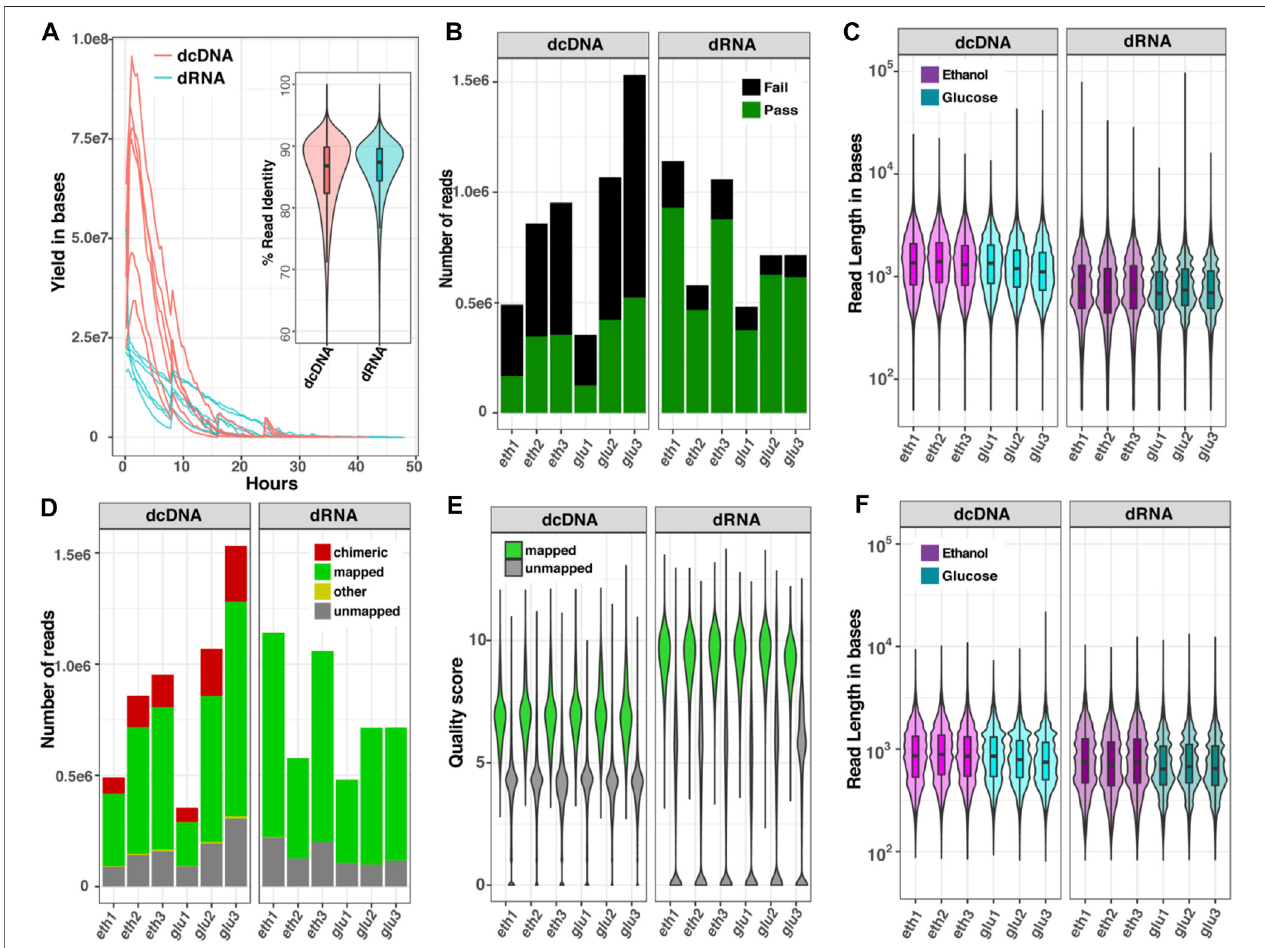
FIGURE2| Comparison ofreadcharacteristicsforsixdatasetsofyeastRNAsequenced asdcDNAordRNA. (A) Sequenceyieldsper hourandviolinboxplot of% read identity; (B) numbers of reads that passed (green) or failed (black) the quality score of 7 by Guppy software; (C) read length distribution of all reads combined (passed plus failed); (D) numbers of all reads that could be mapped to a reference genome; (E) quality score distribution of mapped and unmapped reads; and (F) read length distribution of the reads after removal of chimeric sequences. Data are shown for glucose-grown cells (glu) and for glucose-deprived cells